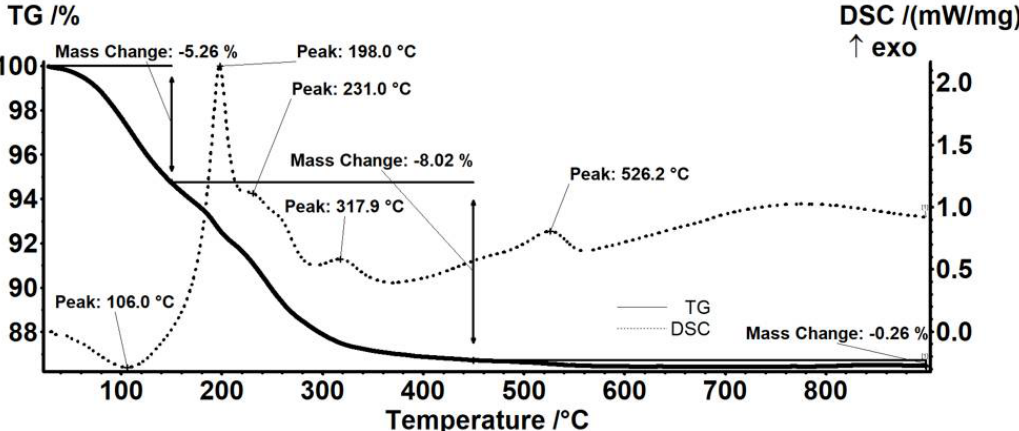
Figure 5. Thermogravimetric analysis of Fe 3 O 4 -NEO nanoparticles.